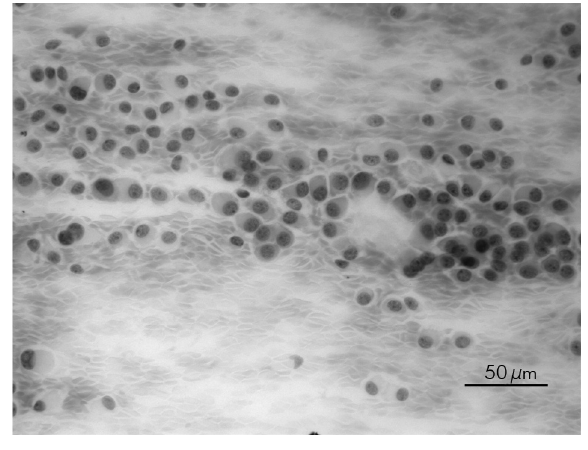
Figure 3. Presence of plasmocitoid cells on the smears with a sugestive report of Pleomorfic Adenoma (H&E stain).